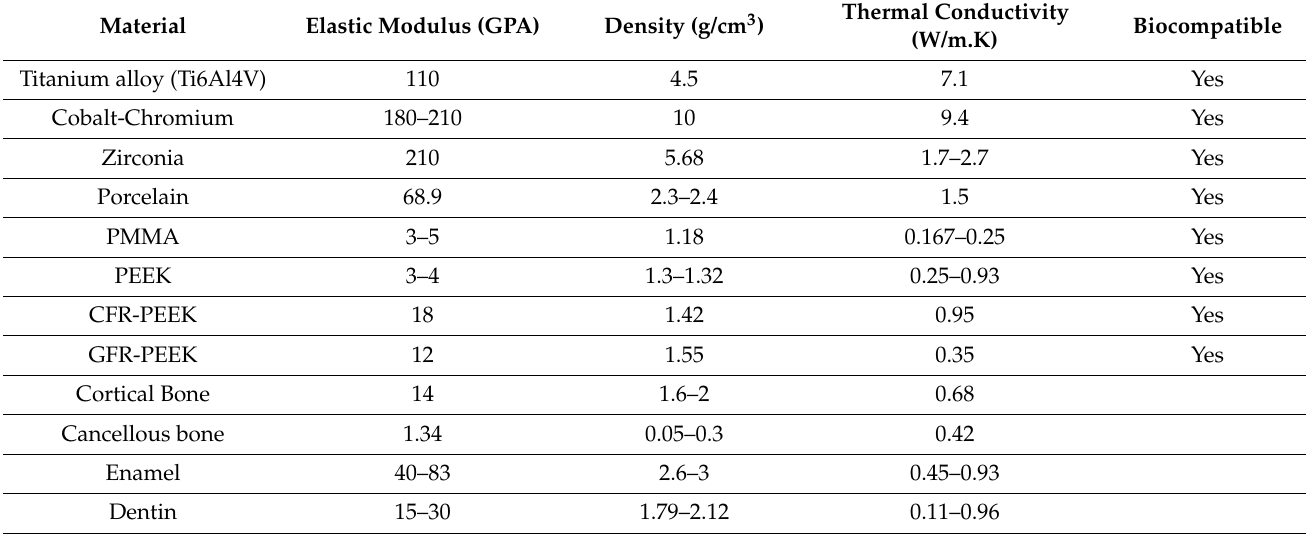
Table 1. Properties of various materials